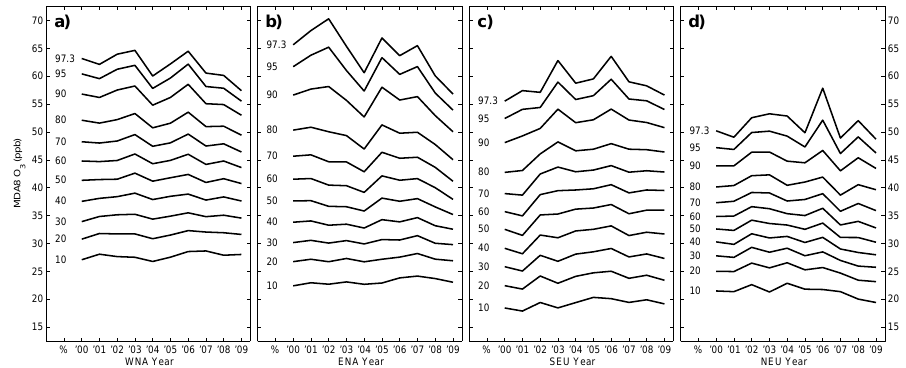
Figure 2. Values of MDA8 O 3 (ppb) for years 2000 to 2009 corresponding to the 10th, 20th,..., 90th, 95th, and 97.3 (i.e., AQX threshold) percentiles in (a) WNA, (b) ENA, (c) SEU, and (d) NEU. The percentile for each line is shown at the beginning of the curves in each panel.